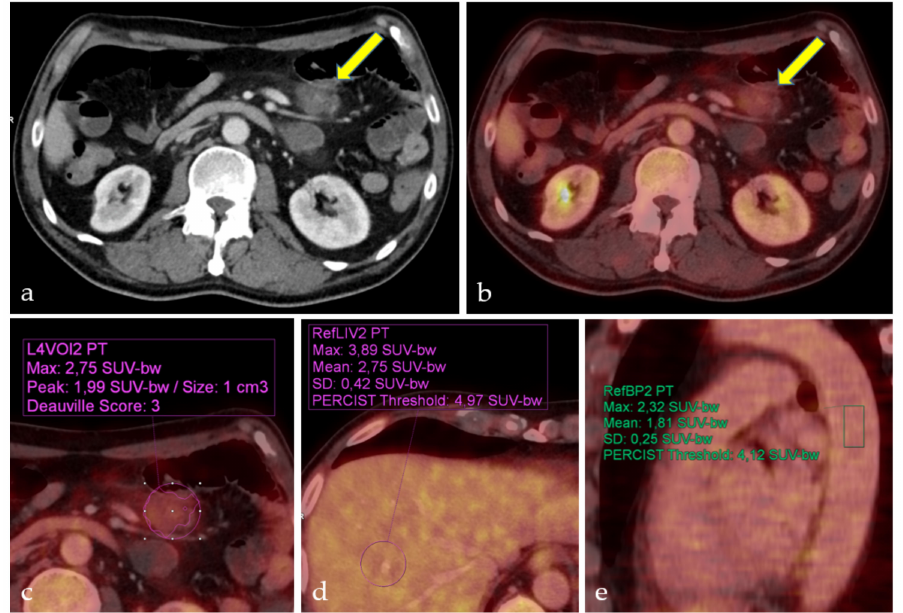
Figure 1. Deauville Score determination of mesenteric follicular lymphoma in stage IV. Patient with mesenteric follicular lymphoma ( a ) CT, ( b ) PET/CT (arrows). Visually assessed Deauville Score 2 ( b ). Semiautomatically calculated Deauville Score 3 ( c ), metabolic activity between liver ( d ) and mediastinal blood pool ( e